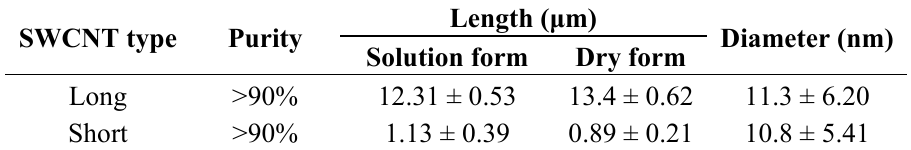
Table 1. Physicochemical Characterization of SWCNTs. The table describes the purity, diameter and length distribution measured via